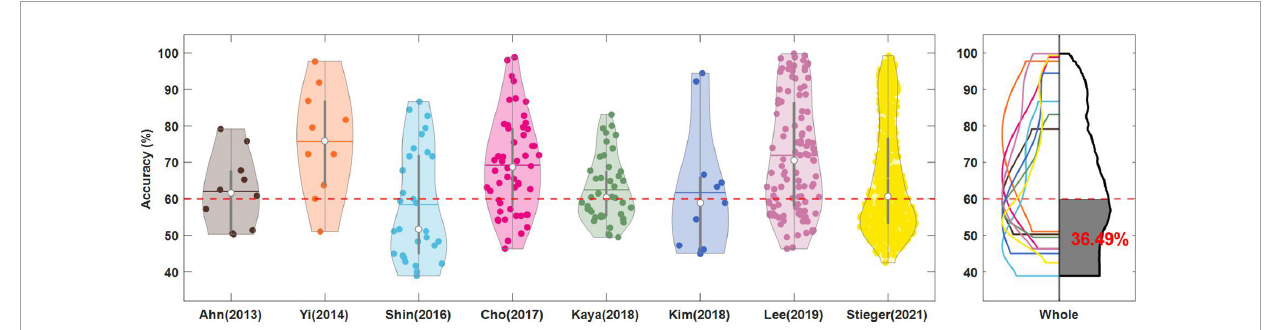
FIGURE3 Classification accuracies of left-right motor imagery. In each dataset, the filled dot represents the individual subject’s accuracy and the average (horizontal line) and median (white circle) of the accuracies are presented. The dotted red line denotes the threshold accuracy (60%) for identifying the low performers (BCI illiterates). In the right panel, the accuracy distributions obtained by Kernel Density Estimation are overlaid and the average of the normalized accuracy distributions is presented in the black lines. The area of low performers based on the threshold accuracy is highlighted in black color and the estimated percentage of the population is written. Kim et al. (2018) was excluded from obtaining the average of normalized accuracy